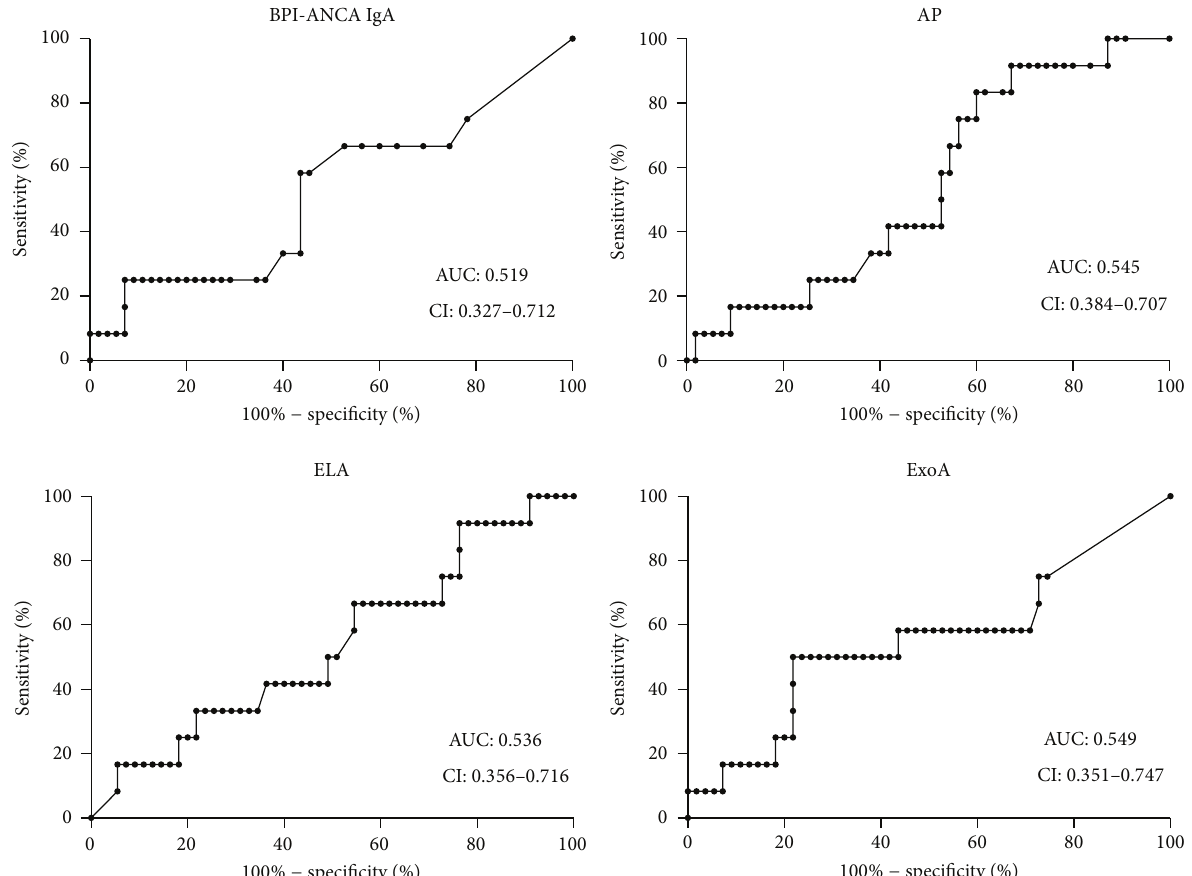
Figure 3: Prediction of future colonization with P. aeruginosa . Patients ( 𝑛 = 12 ) who changed colonization status to chronic (Leeds 1) within three years were identified. Controls were patients staying in Leeds class 2, 3, or 4 (intermittent, free, or never colonized with P. aeruginosa ). ROC-curves were generated to evaluate if any of the four tests (IgA BPI-ANCA, AP, ELA, or ExoA) was able to find these patients three years before the chronic colonization was established. None of the tests could be used for that